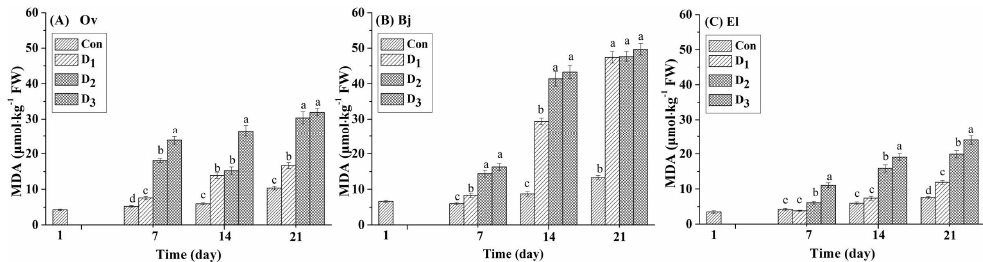
Figure 1. Effect of different levels (Con: 25% moisture, D 1 : 17% moisture, D 2 : 14% moisture, and D 3 : 11% moisture) of drought stress on MDA content ( µ mol/kg FW) in the leaves of three plant species. The different letters above the bars represent significant differences among treatments on the same day ( p < 0.05). ( A ) Orychophragmus violaceus L. (Ov); ( B ) Brassica juncea L. (Bj); ( C ) Euphorbia lathyris L.